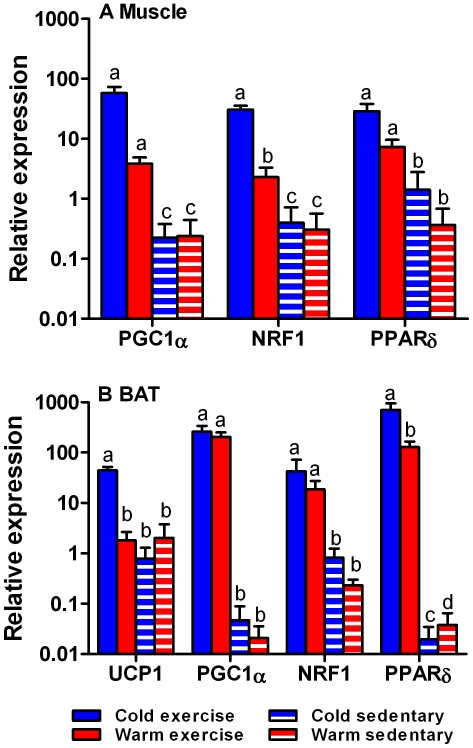
Relative expression of transcription factors and UCP1.Relative expression (mean ± s.e.m) of transcriptional regulators PGC-1α, NRF-1, and PPARδ in skeletal muscle (A) and BAT (B), and UCP1 in BAT (B) from cold exercised (blue bars), warm exercised (red bars), cold sedentary (blue striped bars) and warm sedentary (red striped bars) rats. The relative expression of all genes increased with exercise in both skeletal muscle and BAT. There were significant interactions between thermal acclimation and exercise for NRF-1 relative expression in muscle, and for PPARδ expression in BAT. UCP1 relative expression did not increase in response to either cold or exercise alone, but only when those two stimuli coincided. Significant differences are indicated by different letters above each column.